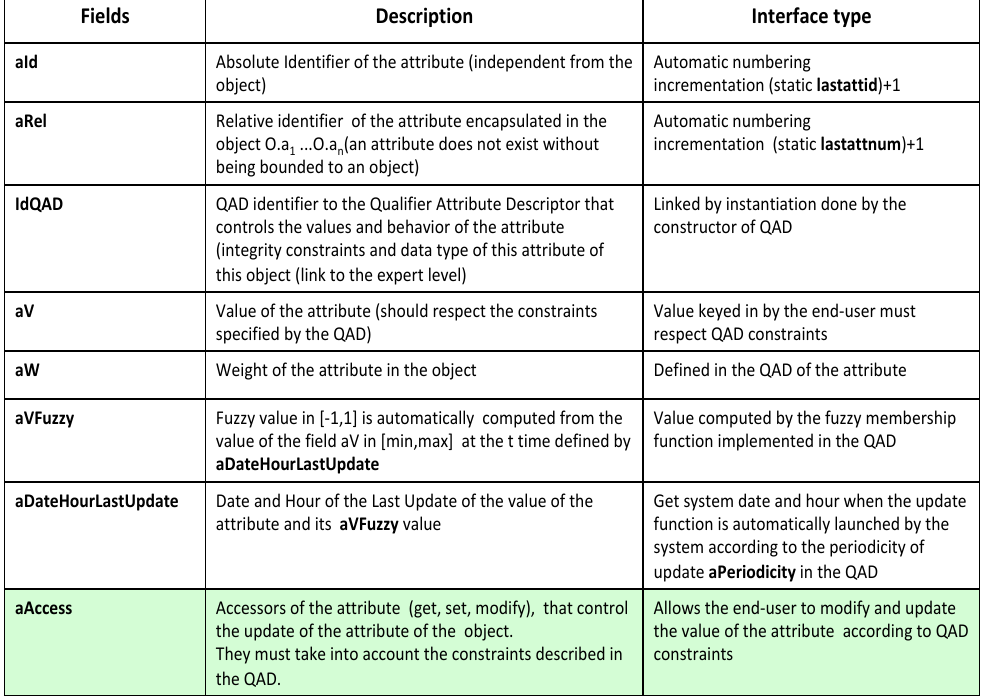
Figure 9. End-user attribute